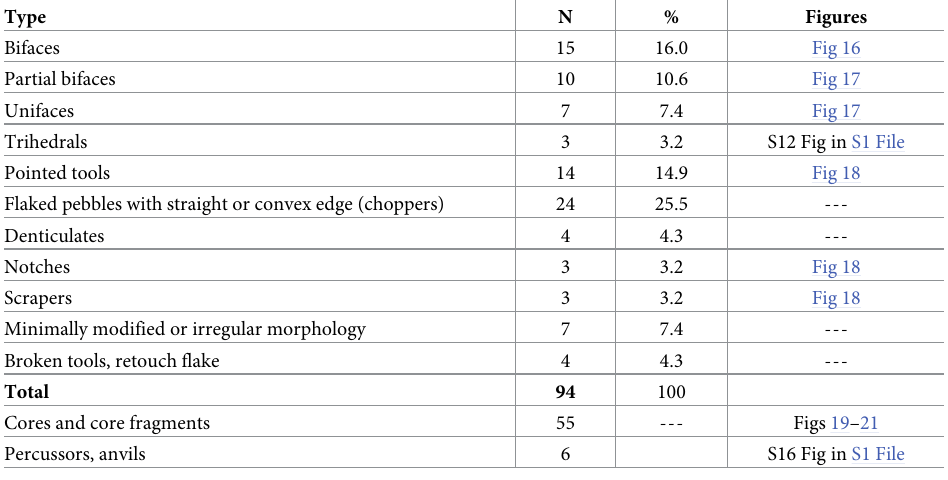
Table 5. Castel di Guido. Counts of stone large tool types ( � 6 cm in maximum dimension) � . Type N